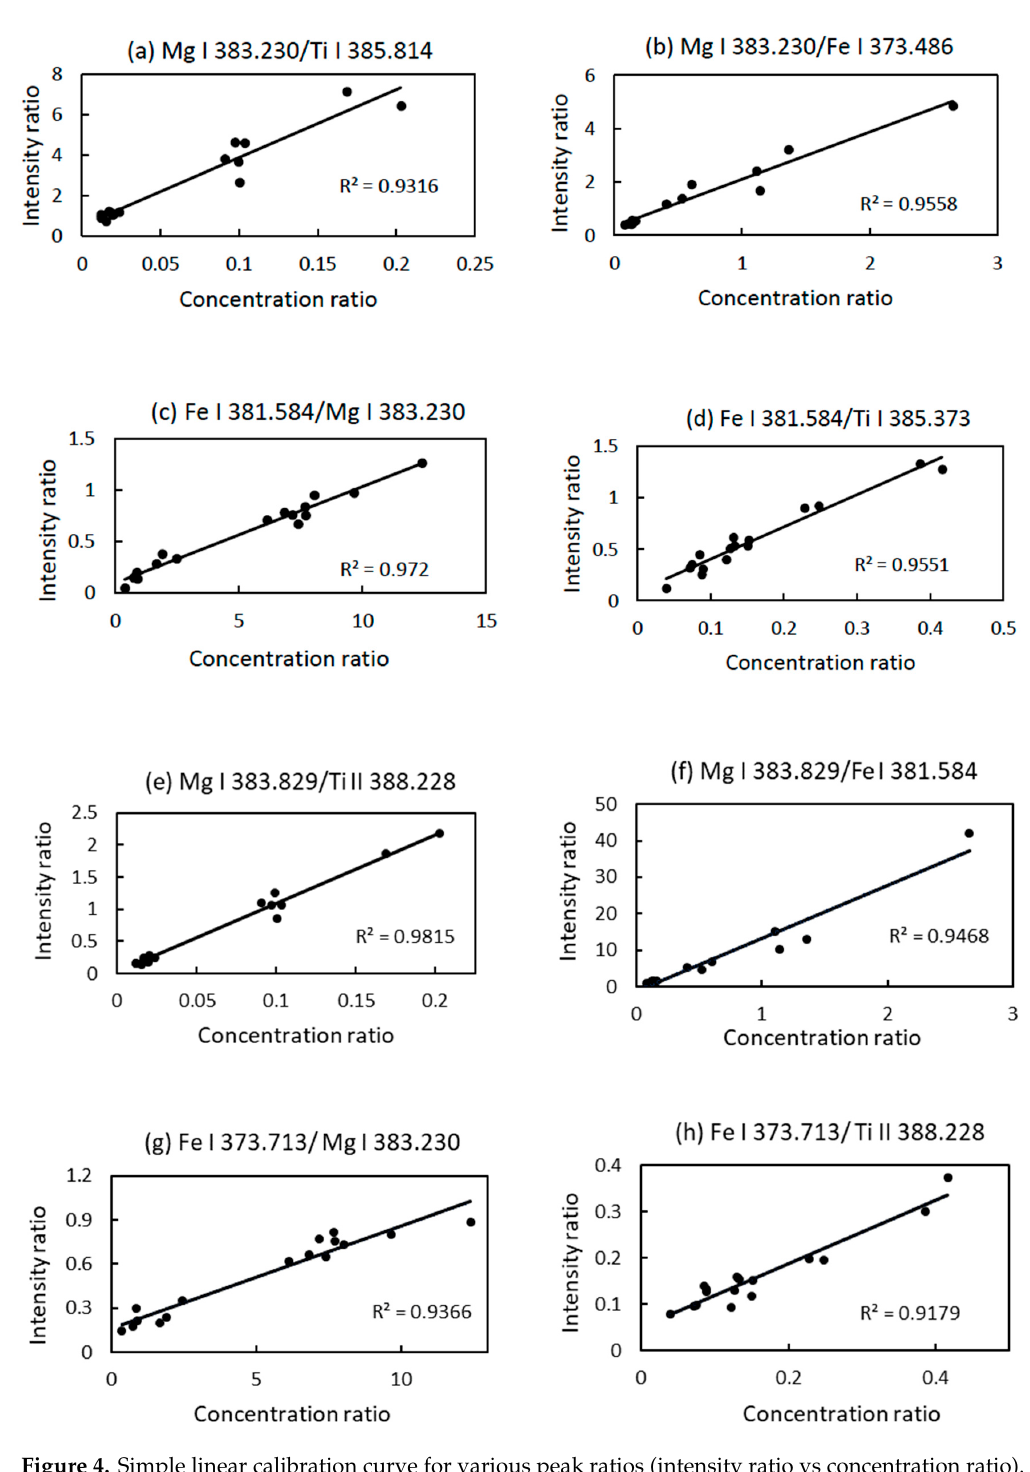
Figure 4. Simple linear calibration curve for various peak ratios (intensity ratio vs concentration ratio). ( a ) Mg I 383.230 / Ti I 385.814, ( b ) Mg I 383.230 / Fe I 373.486, ( c ) Fe I 381.584 / Mg I 383.230, ( d ) Fe I 381.584 / Ti I 385.373, ( e ) Mg I 383.829 / Ti II 388.228, ( f ) Mg I 383.829 / Fe I 381.584, ( g ) Fe I 373.713 / Mg I 383.230, ( h ) Fe I 373.713 / Ti II 388.228.